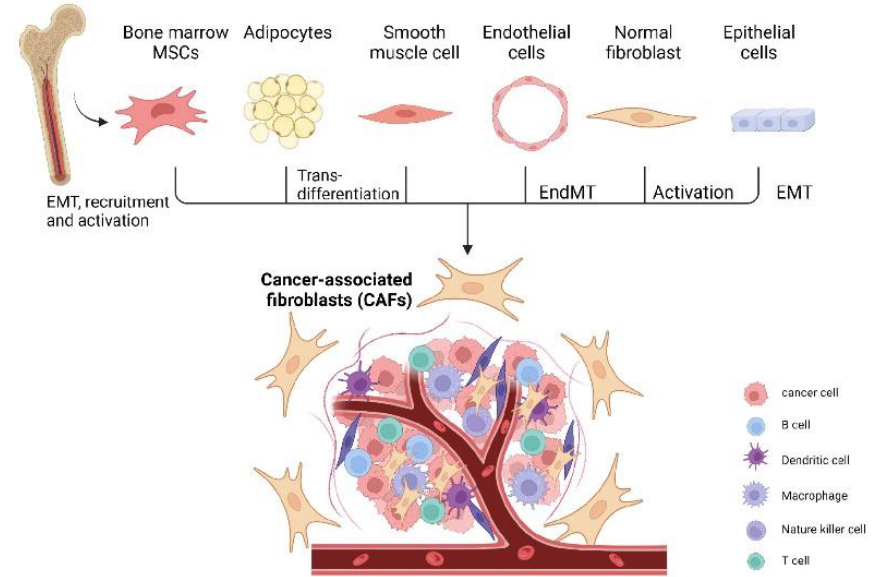
Figure 1. Origins of ovarian cancer-associated fibroblasts. CAFs are important components in the tumor microenvironment and may potentially derive from several cellular sources, including normal fibroblasts (which can convert into CAFs via activation), epithelial cells (through EMT), smooth muscle cells (through trans-differentiation), adipocytes (through trans-differentiation), endothelial cells (EndMT), and bone marrow MSCs (through EMT, recruitment, and activation), among other cells. Image created with BioRender.com (accessed on 19 April 2022). CAFs: cancer-associated fibroblasts; EMT: epithelial-to-mesenchymal transition; EndMT: endothelial-to-mesenchymal transition; MSCs: mesenchymal stem